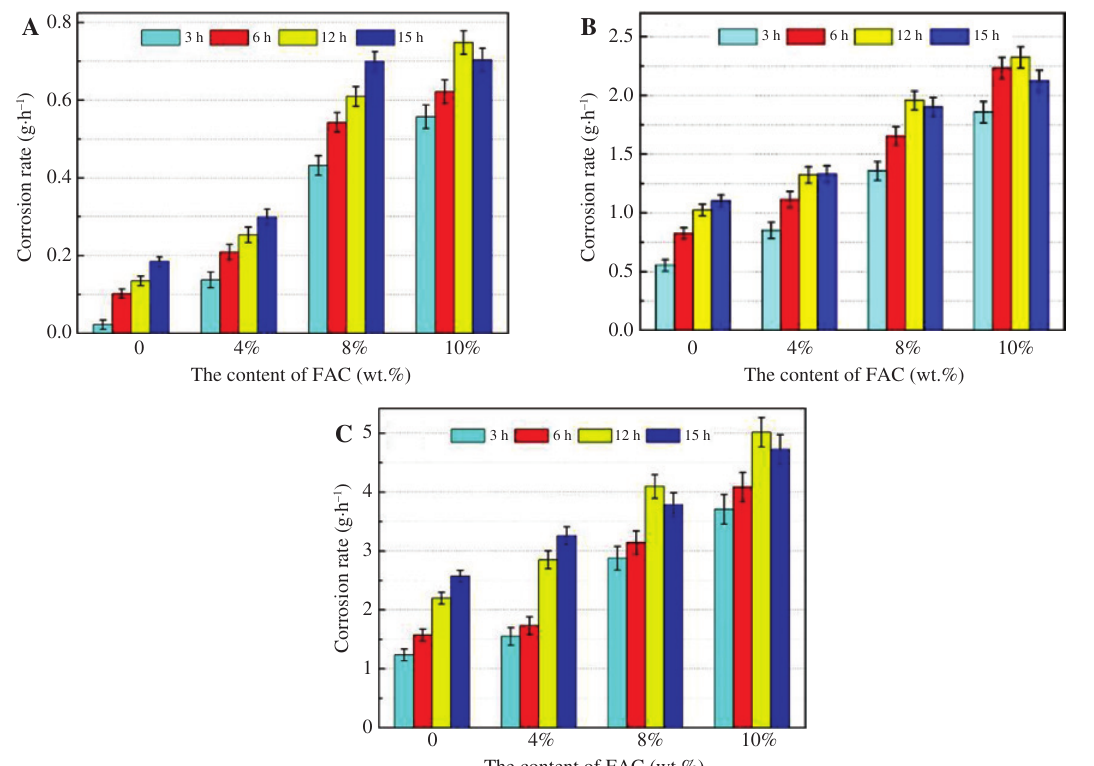
Figure 6: Corrosion rates of the investigated degradable composites in 3% KCl at (A) 25 ° C, (B) 50 ° C and (C) 80 °